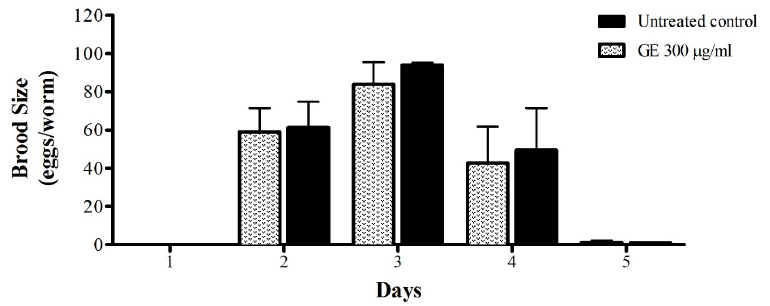
Figure 7. Brood size of N2 (wt) worms after GE treatment. Treatment with GE 300 μ g/mL had no effect on egg laying activity. The results are expressed as mean ± SEM from three independent experiments. Treatment groups are compared to the untreated control by two ‐ way ANOVA.